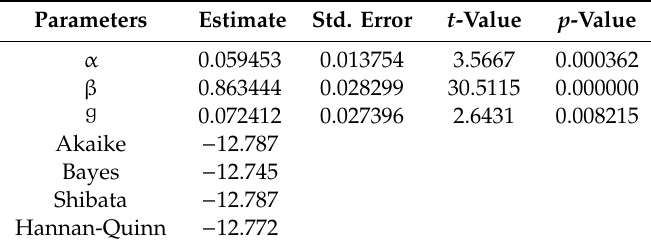
Table A1. Parameter Estimates of Hong Kong’s Islamic-conventional ADCC-GARCH model. Figure A4. Islamic-conventional stock returns Wavelet correlations for Americas’ region markets. Table A5. Parameter Estimates of Denmark’s Islamic-conventional ADCC-GARCH model. Table A2. Parameter Estimates of New Zealand’s Islamic-conventional ADCC-GARCH model.